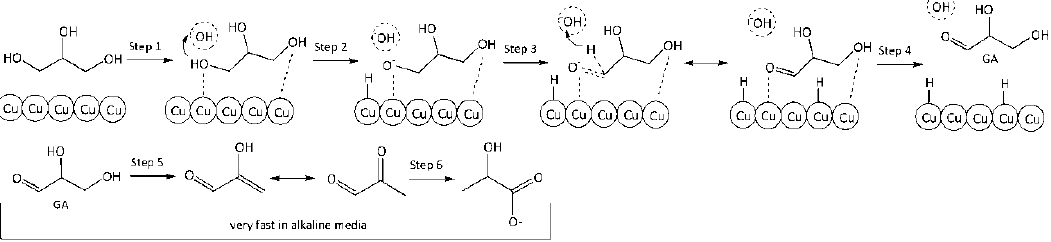
Figure 4. A schematic conversion of glycerol into lactic acid on the surface.